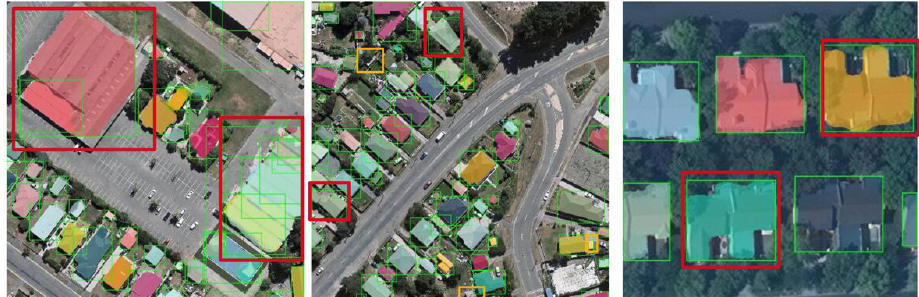
Figure 1. Visualization examples with classical instance segmentation model-Mask R-CNN. Note: the red boxes represent buildings with blurring contours, the yellow boxes represent undetected small buildings and the green boxes are generated by Mask